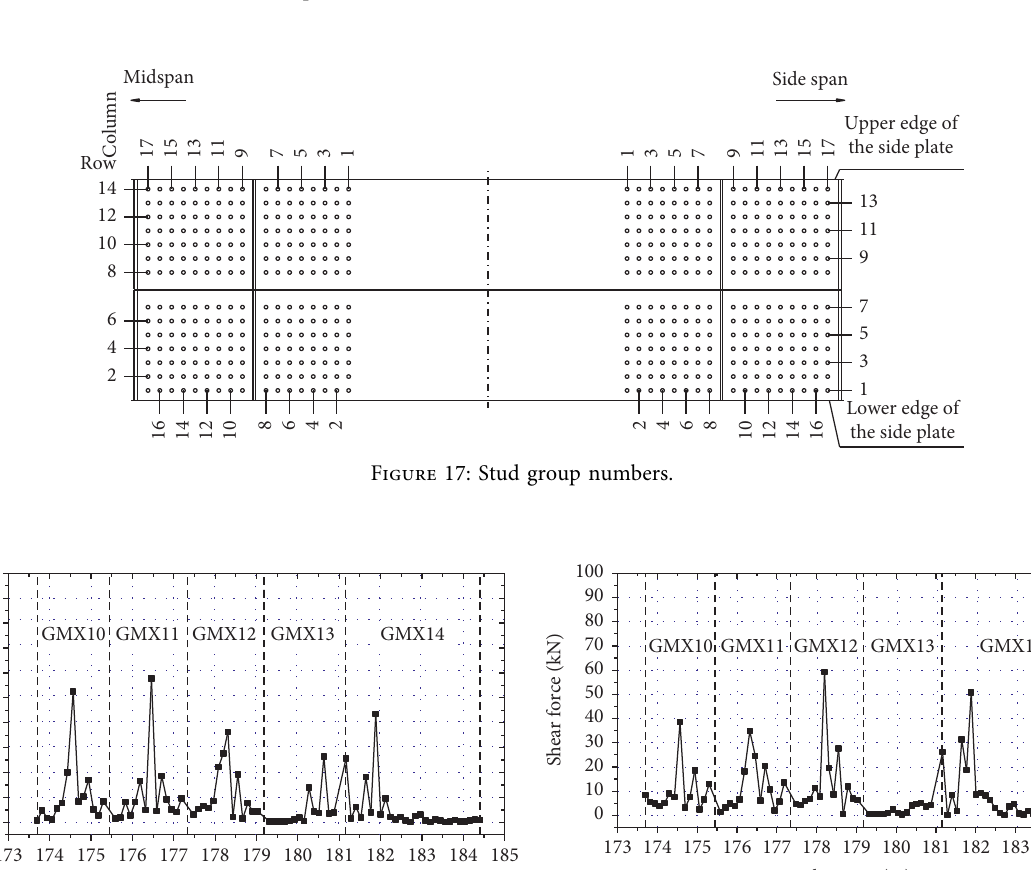
Figure 16: Principal tensile stress distributions of the concrete cable tower (MPa).